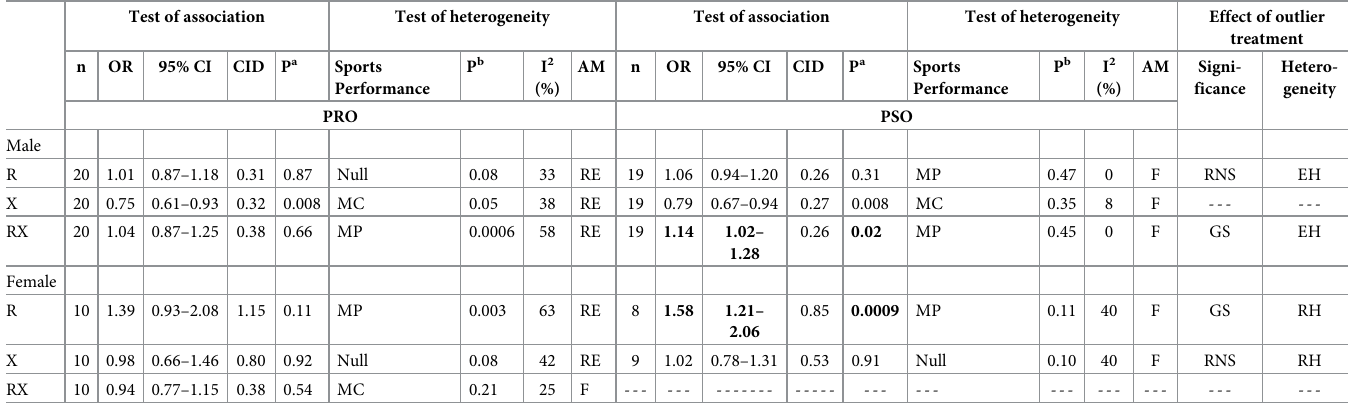
Table 2. Gender analysis in ACTN3 R577X polymorphism with power sports.